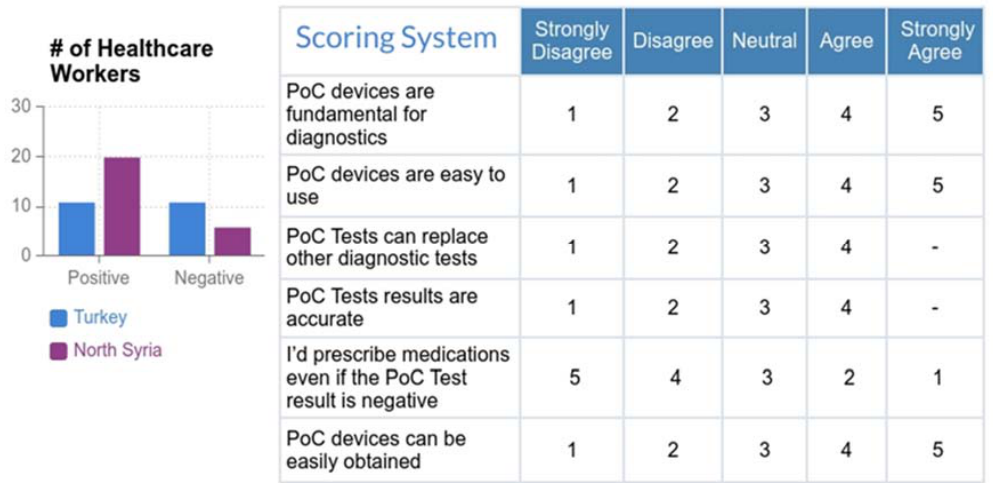
Figure 2. Healthcare workers’ attitudes towards PoC devices . ( Left ) Total number of surveyees was 48 healthcare workers: 22 from Turkey and 26 from North Syria. Surveys are collected anonymously online in both Turkish and Arabic: https://globalchallenges.ku.edu.tr/ (20–31 January 2021). The number of healthcare workers who were positive or negative towards PoC devices is represented based on the country, and shows that healthcare workers in North Syria are more positive compared to those in Turkey. ( Right ) Criteria used to determine the positivity or negativity towards PoC devices and the results based on work location. A total score between 10 and 18 indicates negativity towards PoCs. A total score of 19–28 indicates positivity towards PoCs.